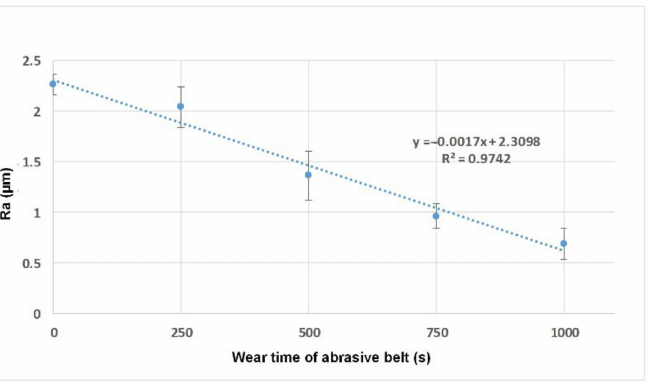
Figure 18. The scatter diagram of the measured Ra versus the abrasive belt with different degrees of wear.